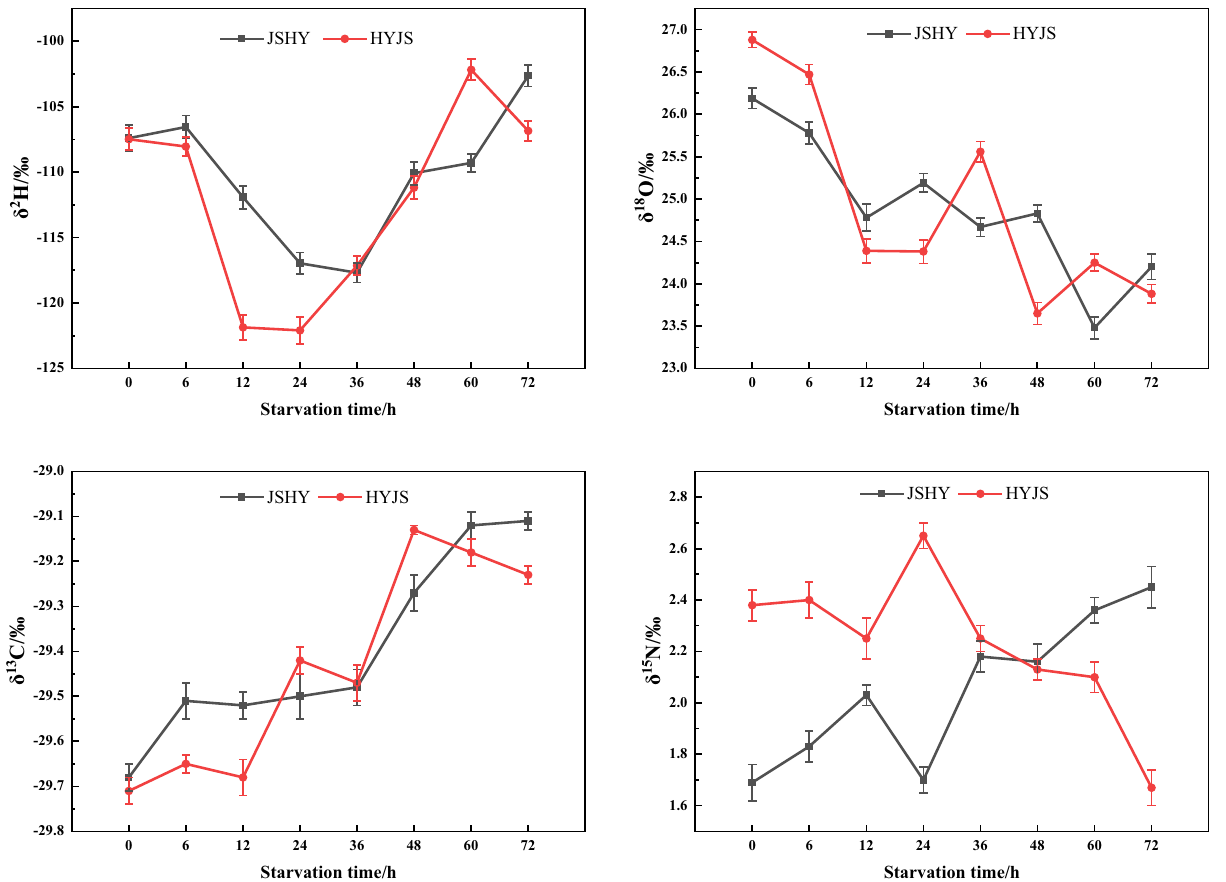
Figure 7. Distribution of stable hydrogen, oxygen, carbon, and nitrogen isotope compositions under starvation